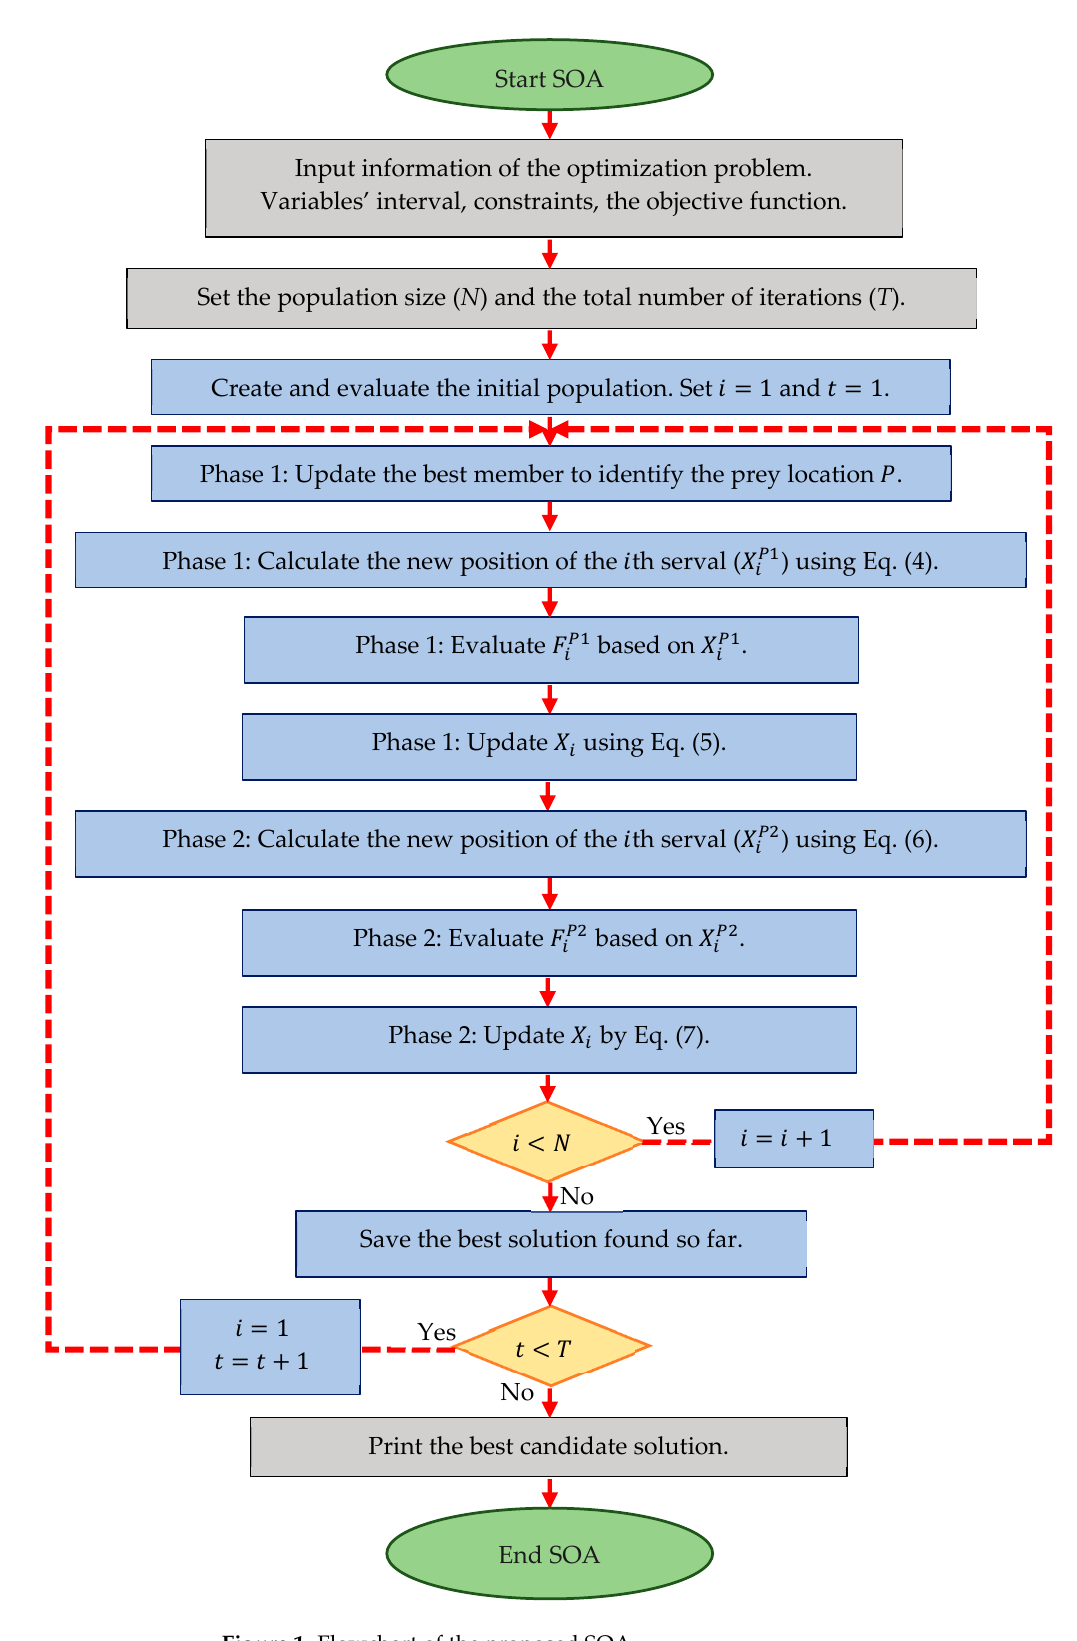
Figure 1. Flowchart of the proposed SOA.